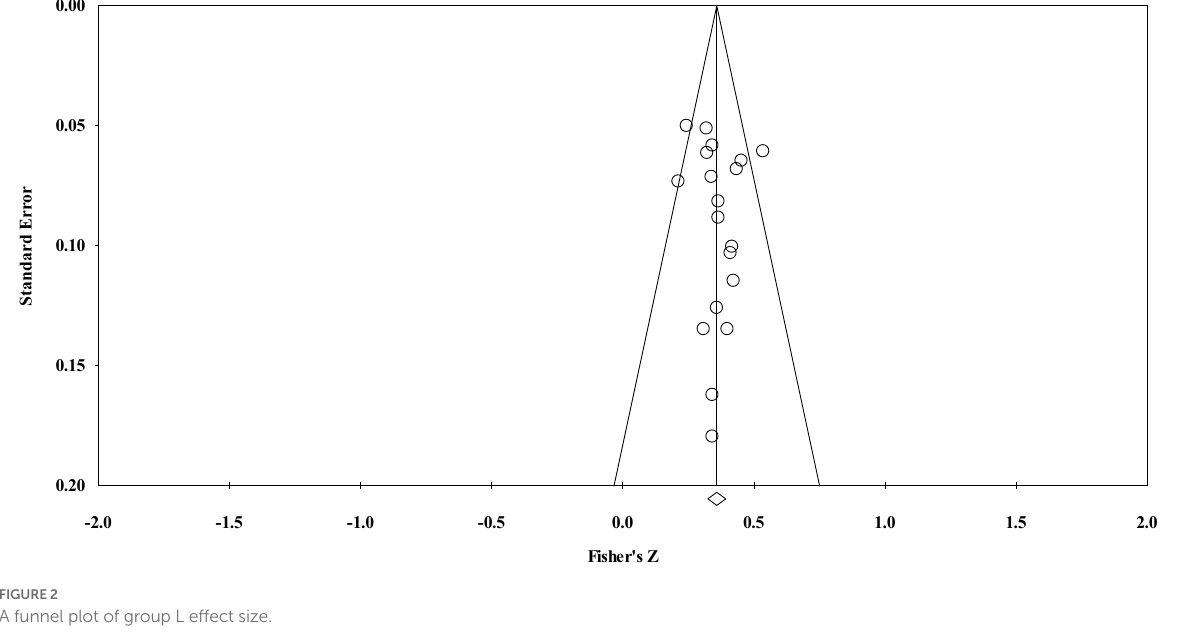
FIGURE 2 A funnel plot of group L effect size.